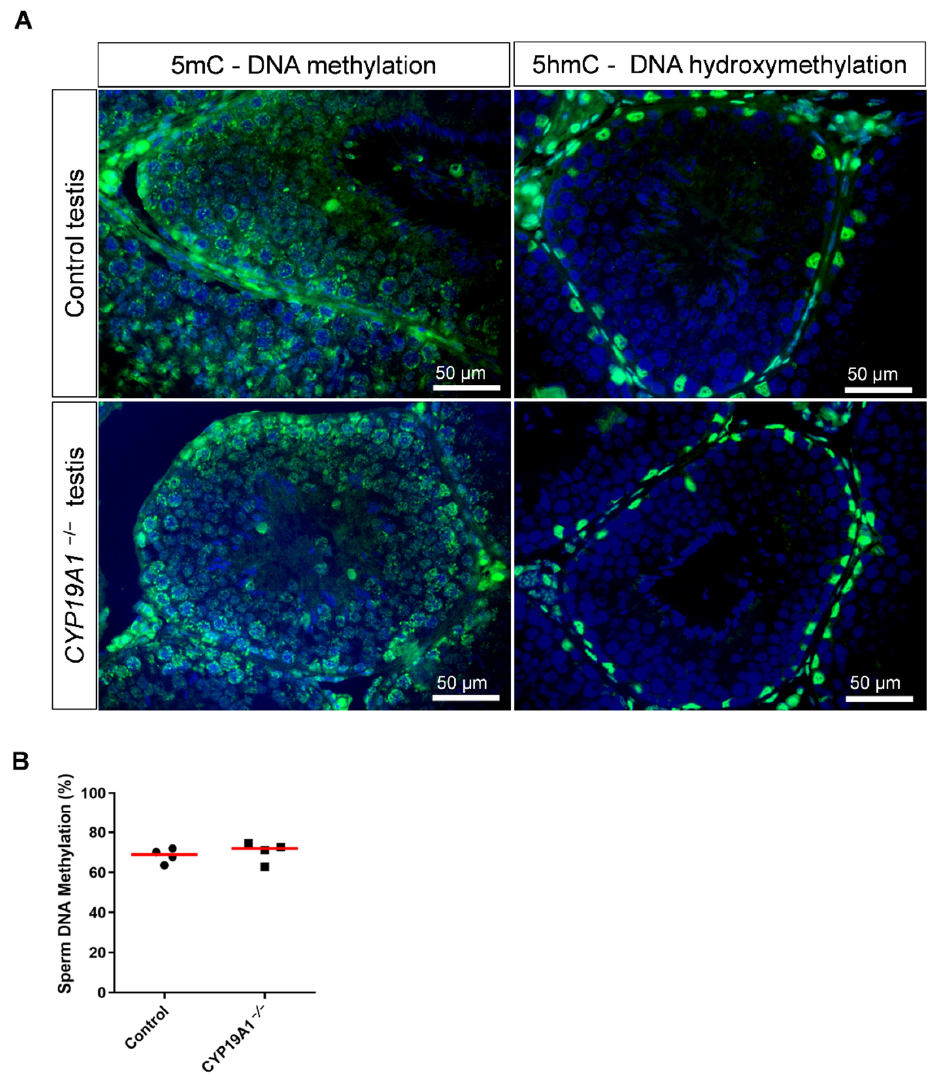
Figure 6. DNA methylation in the testis and sperm in absence of estrogen synthesis. ( A ) Immuno ‐ detection of 5mC and 5hmC in control and CYP19A1 − / − testis (green). Nuclei were stained in blue (DAPI). ( B ) Percentage of sperm DNA methylation from control and CYP19A1 − / − male rabbits deter ‐ mined by Luminometric Methylation Assay (LUMA). The median is shown in red. Mann–Whitney test: nonsignificant.